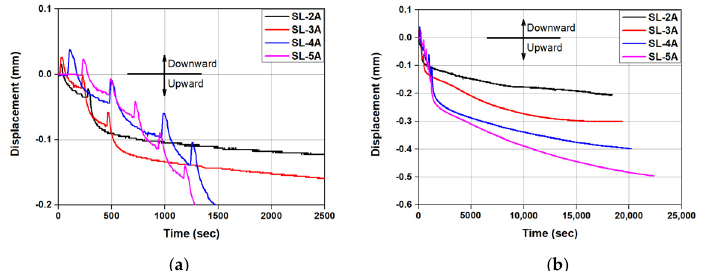
Figure 7. Time–displacement relationship according to amount of Fe-SMA rebar. (a) Heating region. (b) Cooling region.